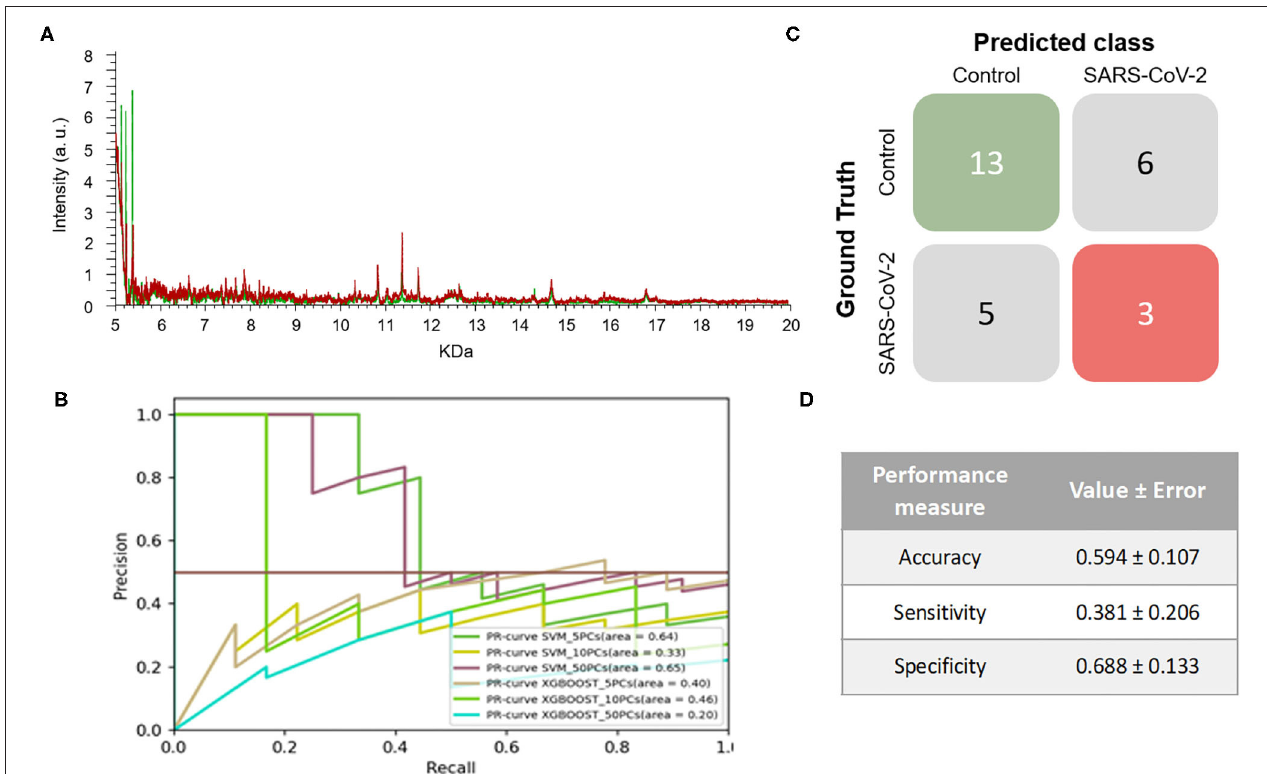
FIGURE 3 | Results for DeltaSwab-Virus (VTM2). (A) Representative mass spectra of NP samples for SARS-CoV-2: positive (red) and negative (green). (B) Precision-recall curve from the different models. (C) Average confusion matrix and (D) average performance metrics including their standard deviation (the test was performed 20 times selecting randomly different samples for each iteration) of the best model (SVM + 10 PCs cross-validation K =